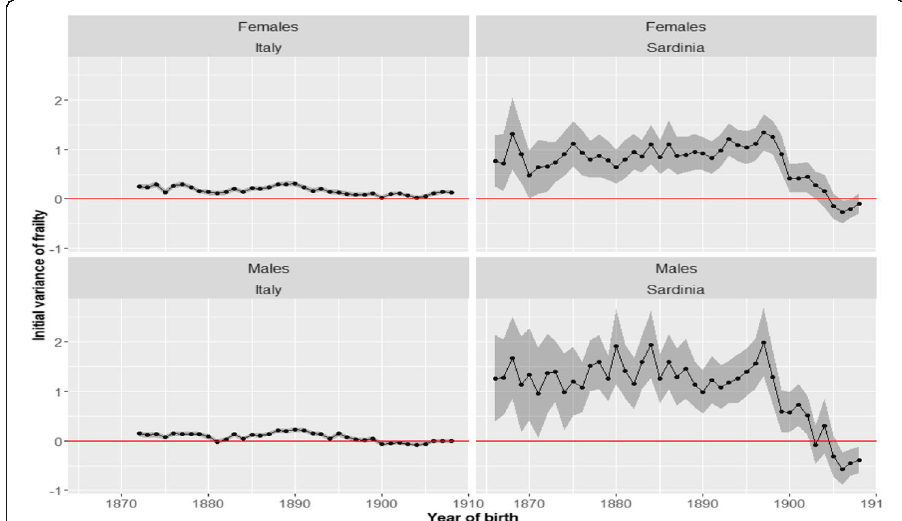
Fig. 8 Estimated initial variance of frailty. Note : Each point represents the estimate of the σ 2 parameter of Eq. (1) for a given cohort. Source : ISTAT and